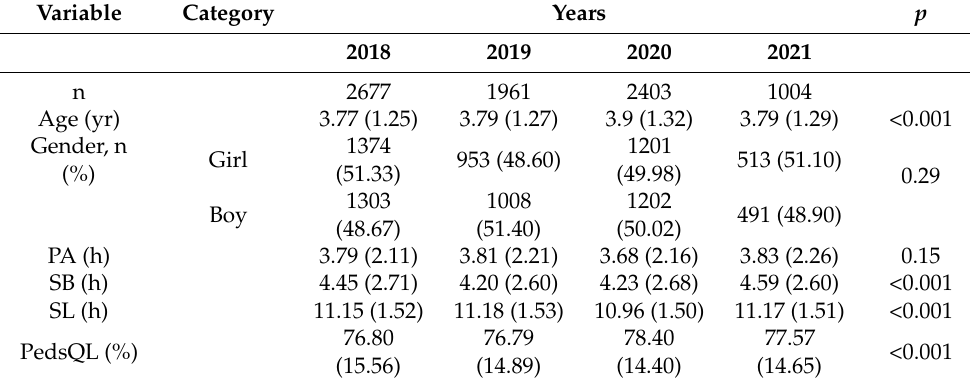
Table 1. Descriptive characteristics of the cross-sectional study sample from 2018–2021.